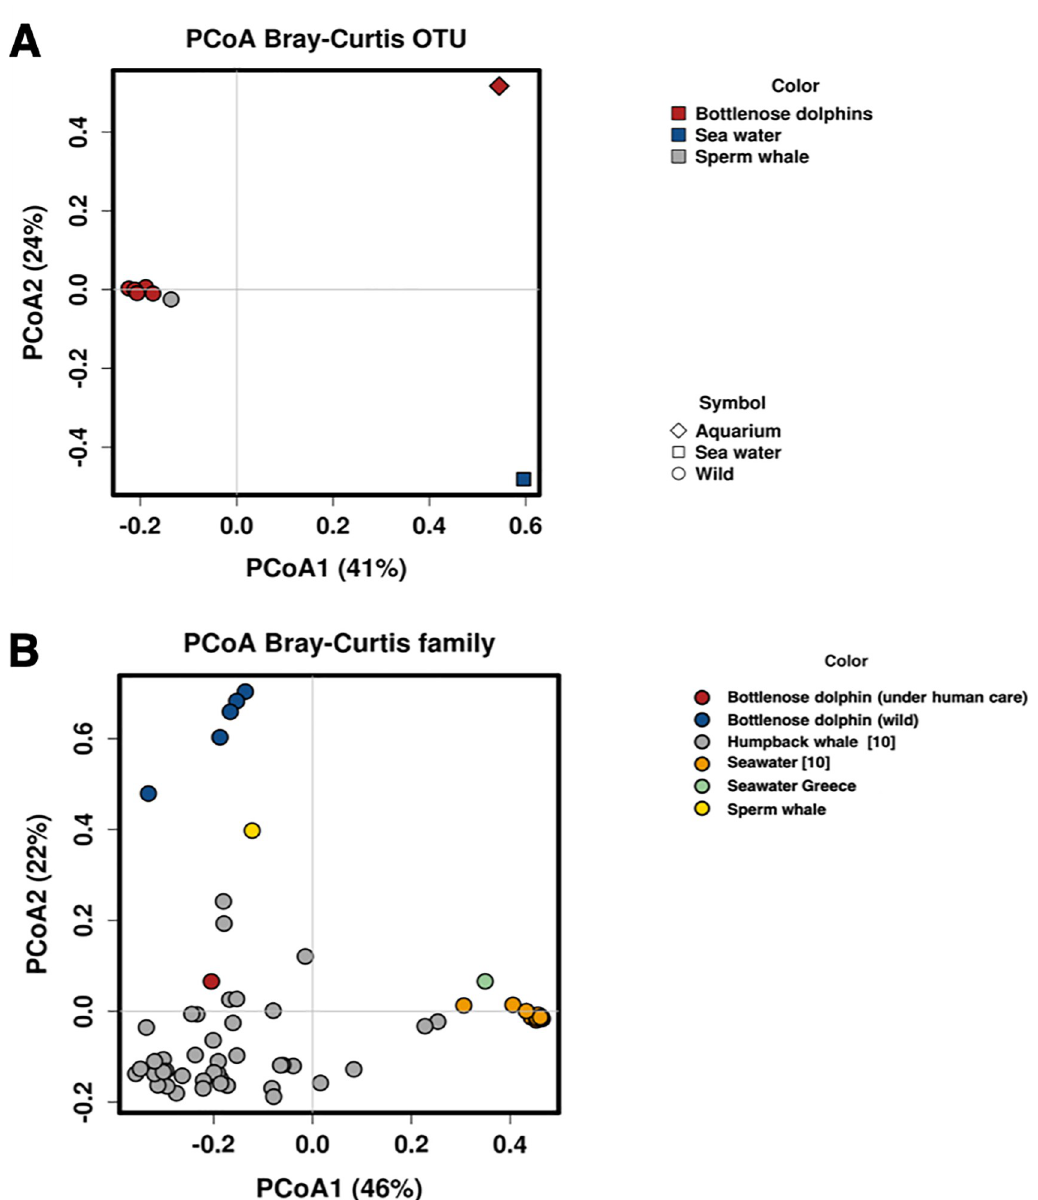
Fig 6. Principal coordinate analysis (PCoA): (A) PCoA of blow microbial community from wild and under human care bottlenose dolphins, sperm whale, and the pooled seawater sample. It’s possible to visualize a greater similarity between different species when sampled in the wild (sperm whale and bottlenose dolphin samples), while there was distance between the same species (bottlenose dolpdhin) sampled in wild vs. kept under human care. Seawater communities were distinct from all other samples. (B) PCoA of blow microbial community obtaining from meta-analysis by adding public data [10] to our dataset.